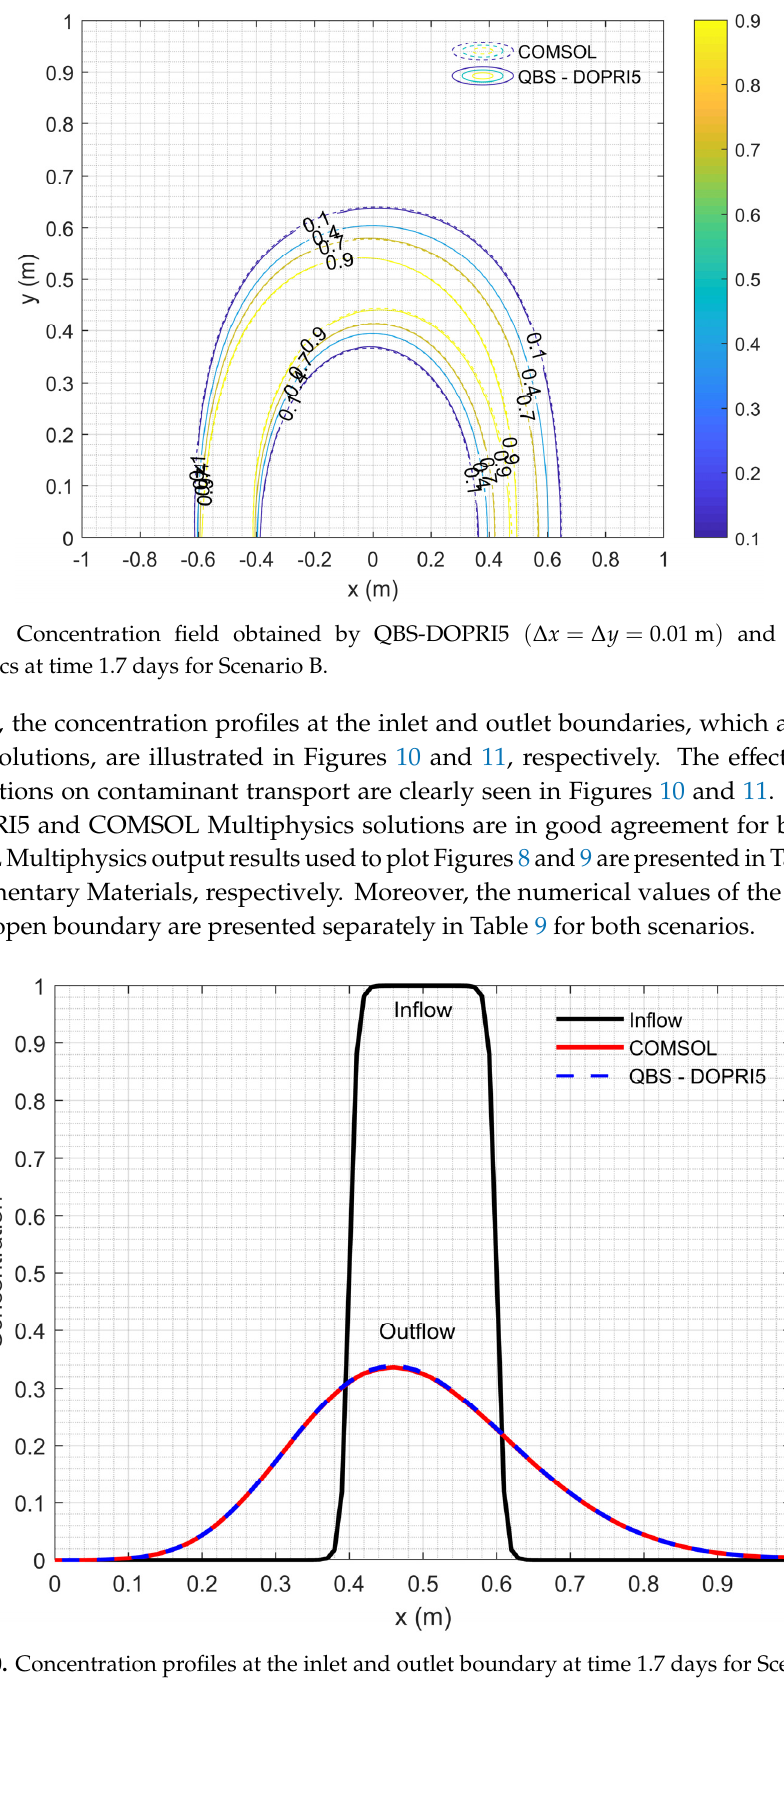
Figure 8. Concentration field obtained by QBS-DOPRI5 (∆(cid:1876) = ∆(cid:1877) = 0.01 m) and COMSOL Multiphysics at time 1.7 days for Scenario A.